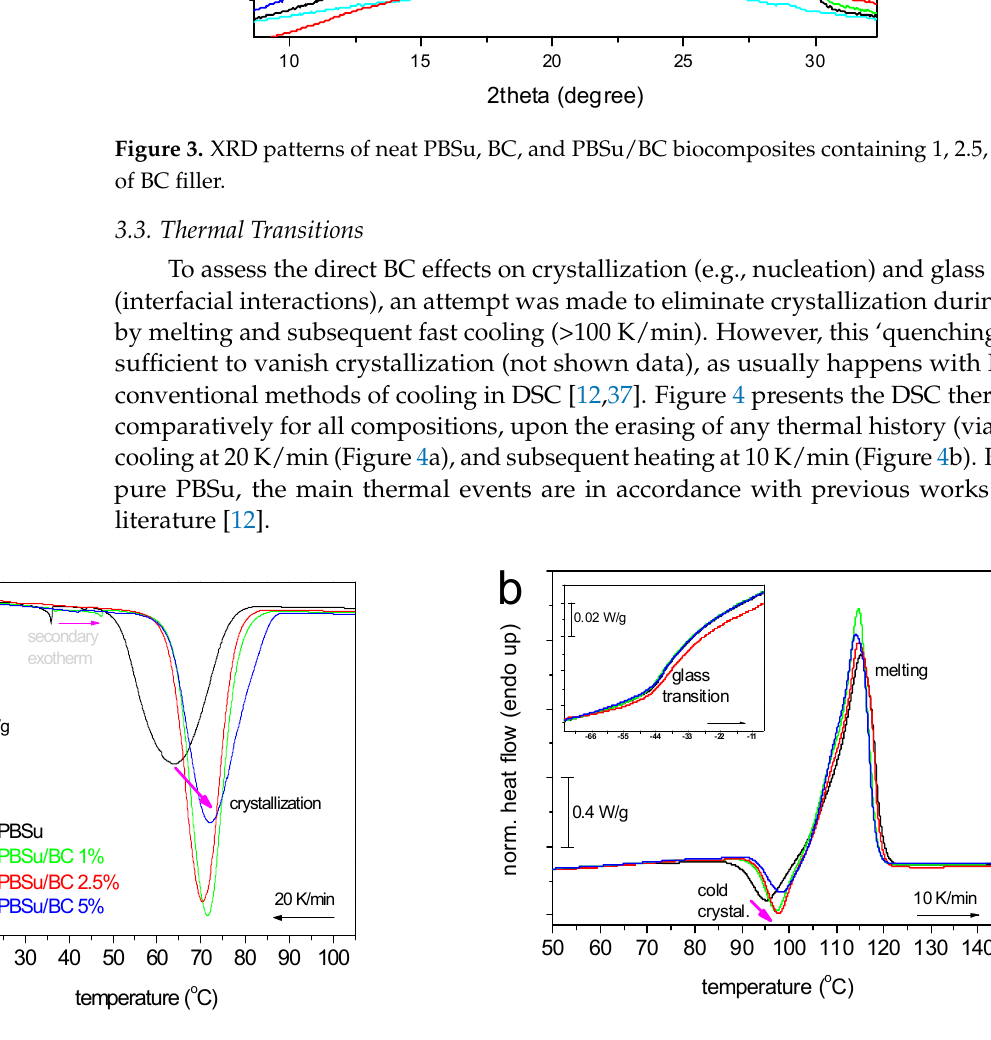
Figure 4. Comparative DSC traces for all samples during ( a ) cooling from the melt state and ( b ) subsequent heating. The added arrows mark the effects of the BC addition to the crystallization events. The inset to ( b ) shows a focus on the glass transition region.